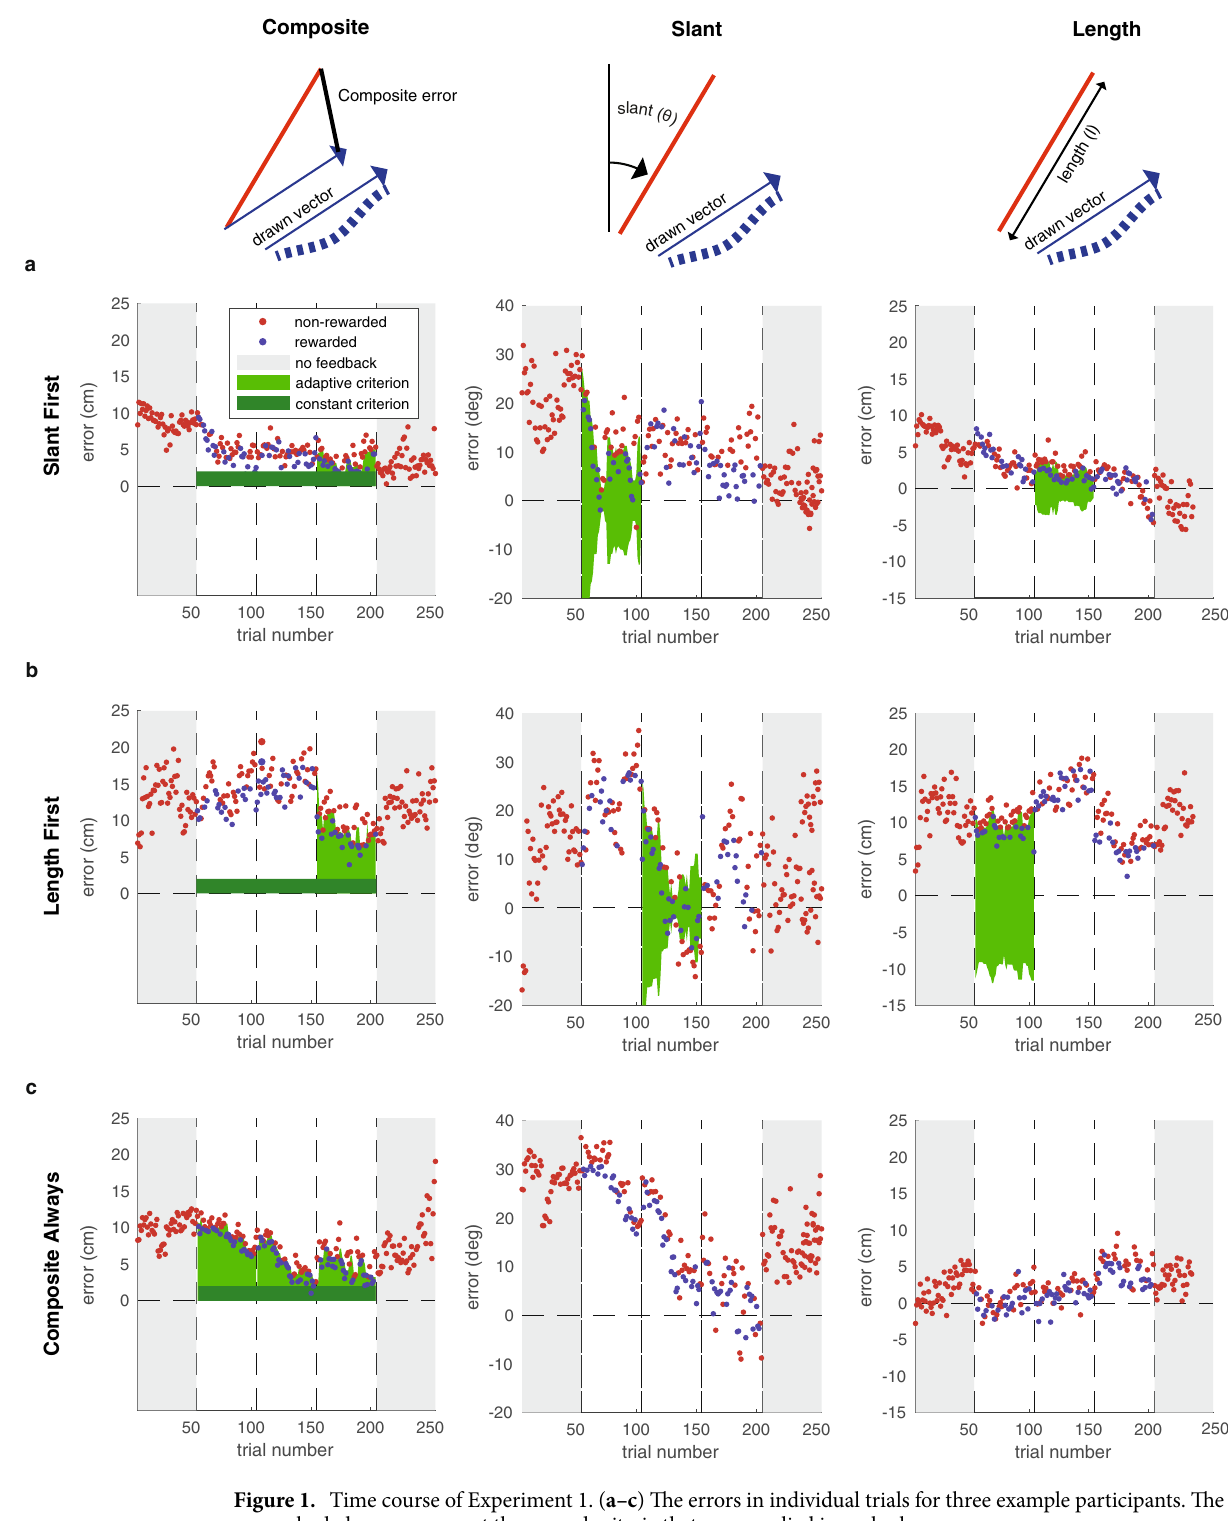
Figure 1. Time course of Experiment 1. ( a–c ) The errors in individual trials for three example participants. The green shaded areas represent the reward criteria that were applied in each